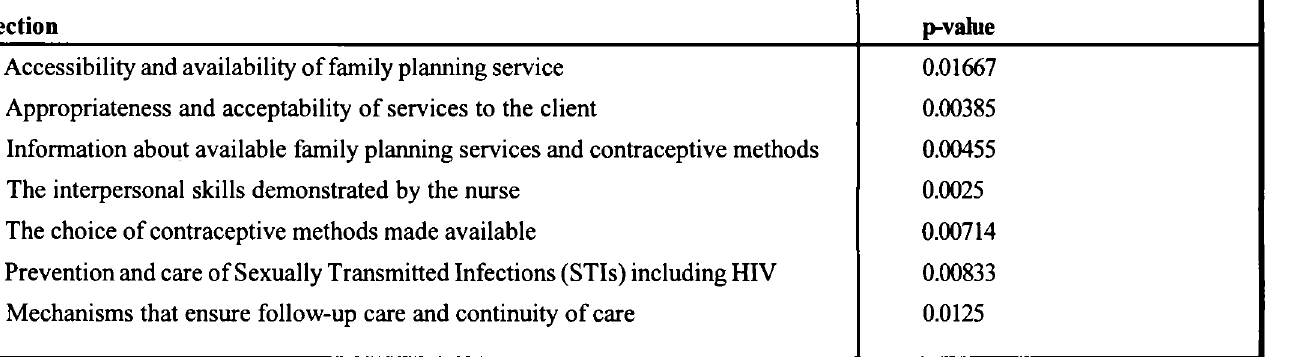
Table 2: p-values for each section of the